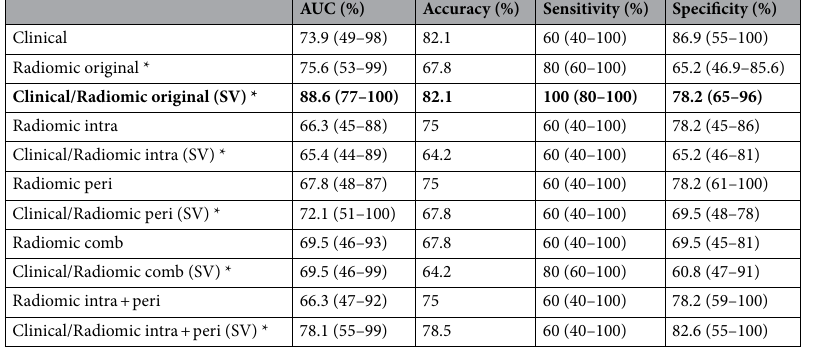
Table 2. Classification performances of all models on the hold-out test set. For each radiomic feature set, the performances of both the related radiomic-based model and the soft voting-based model are reported. The best result is highlighted in bold. Statistical quantifications were demonstrated with 95% confidential interval (CI), when applicable. The asterisk * highlights models whose AUC resulted statistically significant with a p-value less than 0.05.